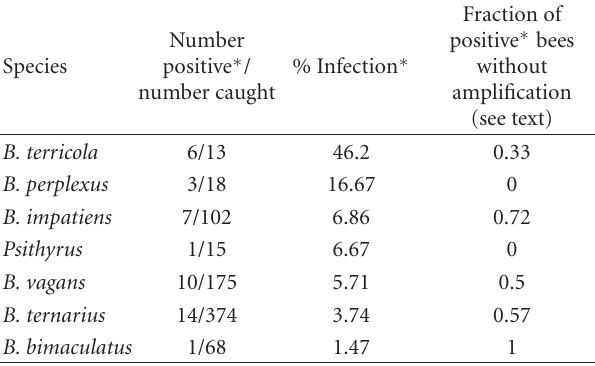
Table 3: Nosema infection in bumblebee species collected in Maine blueberry fields over two years (2009-2010) based on microscopic and molecular